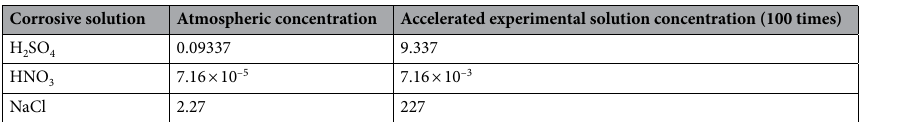
Table 2. Solution concentration for accelerated salt fog corrosion